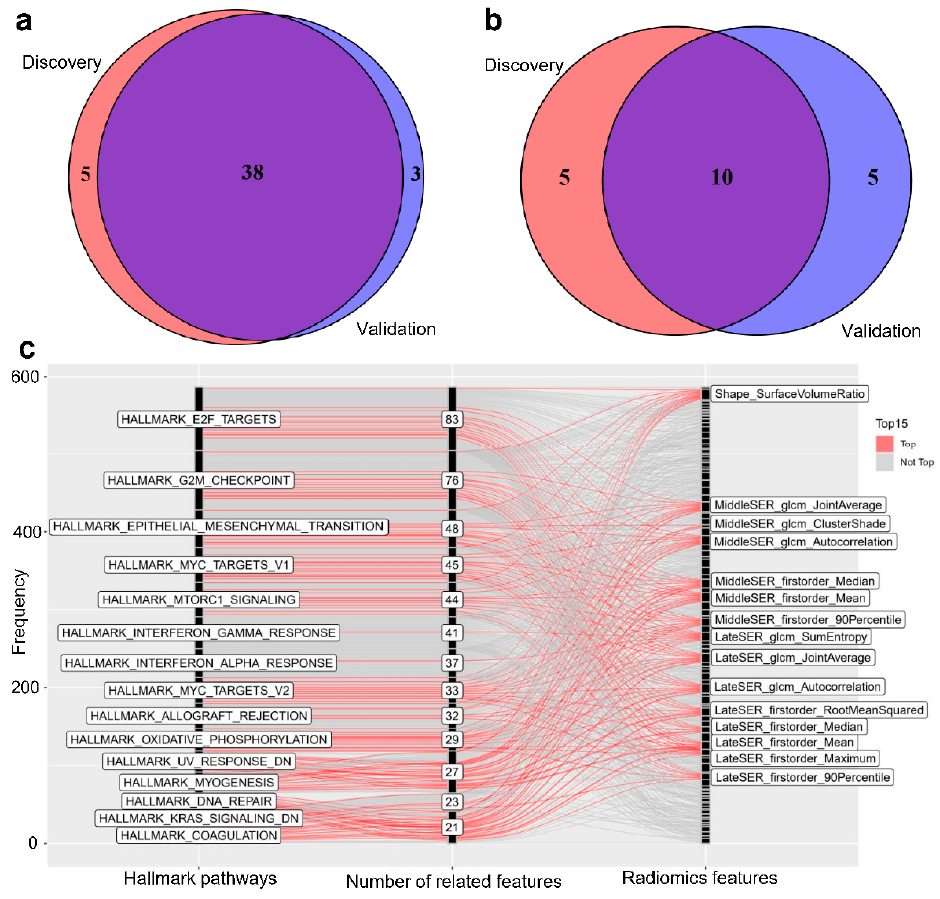
Figure 3. Hallmark pathways with significant imaging correlation were highly overlapping in both cohorts. The distribution of the pathways related to imaging features in the discovery and validation cohorts, shown in ( a ) and ( b ), presents the overlap of the top 15 pathways in the discovery dataset and the top 15 pathways in the validation dataset, as ordered by the number of significant associations. The details of the top 15 hallmark pathways and the top 15 DCE-MRI features of the discovery cohort are presented in ( c ), and the numbers on the middle axis represent the number of significant associations.